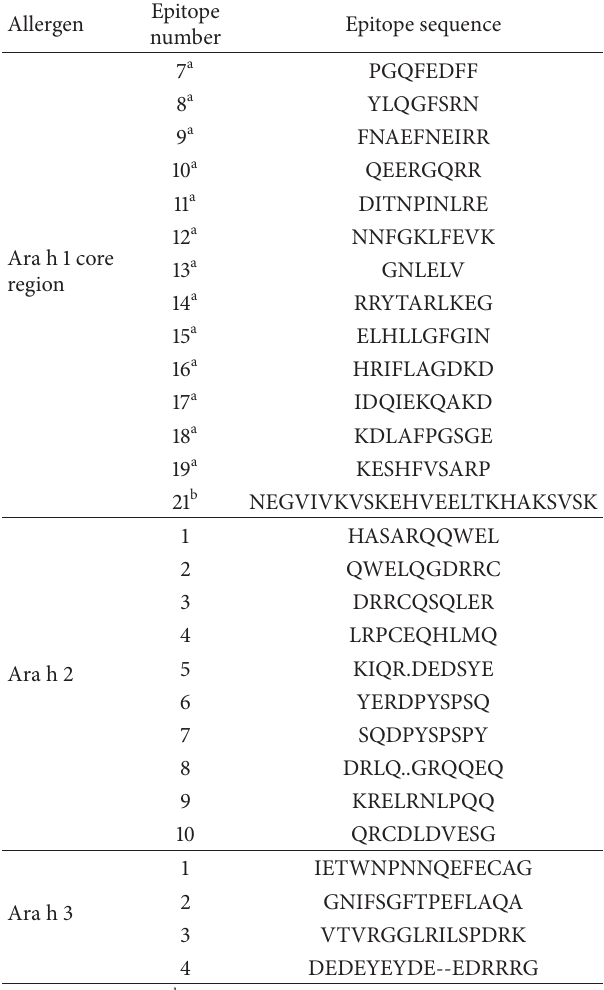
Table 2: Sequence of linear epitopes of peanut allergens [17, 19, 26,